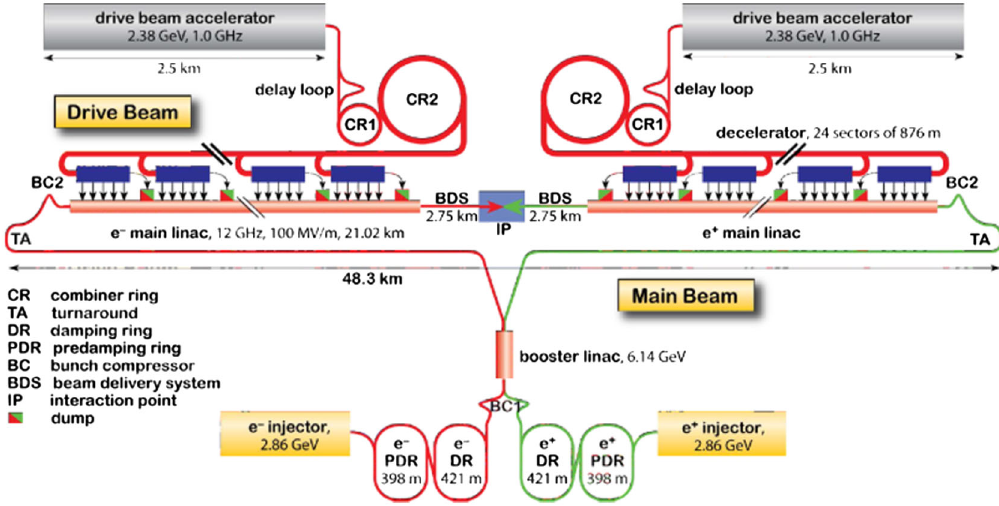
structures.FIG. 1. CLIC layout (not to scale). The main beams are accelerated at the center of the complex using the rf power extracted from the drive beam in the power extraction and transfer structures (PETS blue boxes)